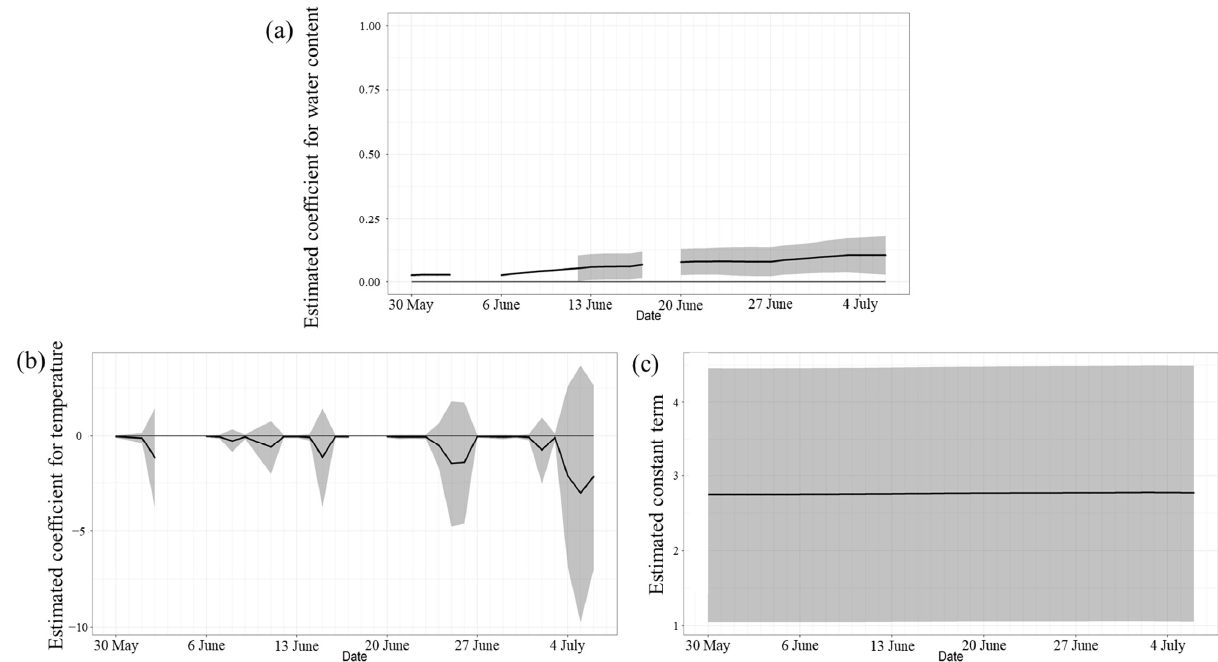
Figure 7. ( a ) Estimation of water content at Shirahama Beach. ( b ) Estimation of temperature at Shirahama Beach. ( c ) Estimation of the constant term at Shirahama Beach. The gray hatches in the fi gures indicate the 95% con fi dence intervals of the estimated values.